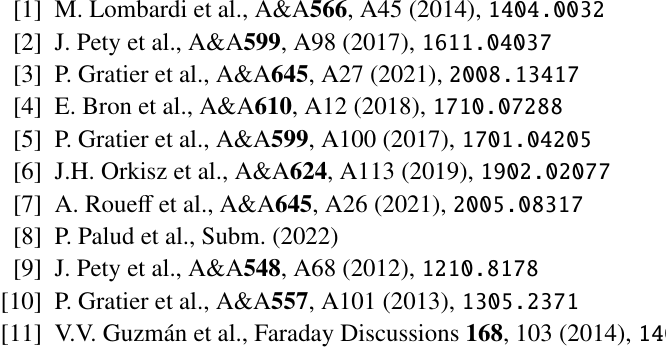
0) emission map (middle, − 1) integrated emission map −